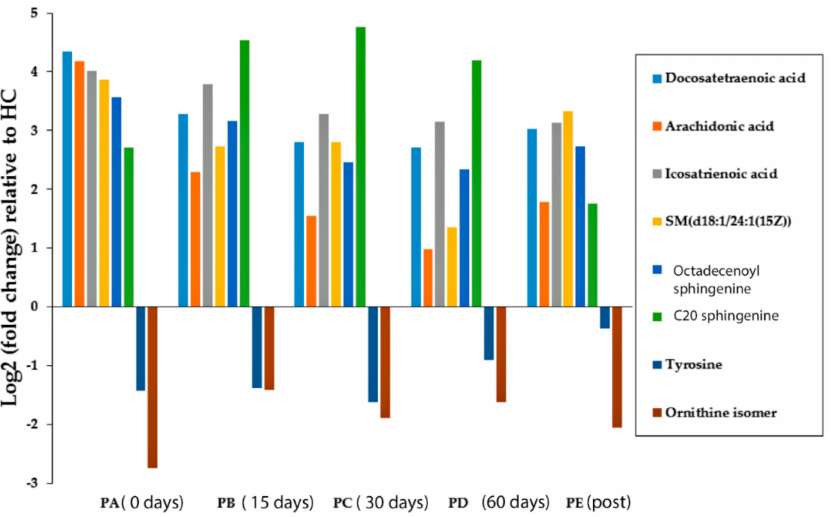
Figure 3. Log2 of the fold-change in the eight differentiated metabolites in the CD groups (before, during, and after EEN treatment) compared with the group of healthy controls. (HC) Healthy control children, (PA) CD children pre-EEN treatment, (PB) CD children 15 days during EEN treatment, (PC) CD children 30 days during EEN treatment, (PD) CD children 60 days during EEN treatment, (PE) CD children back to a free